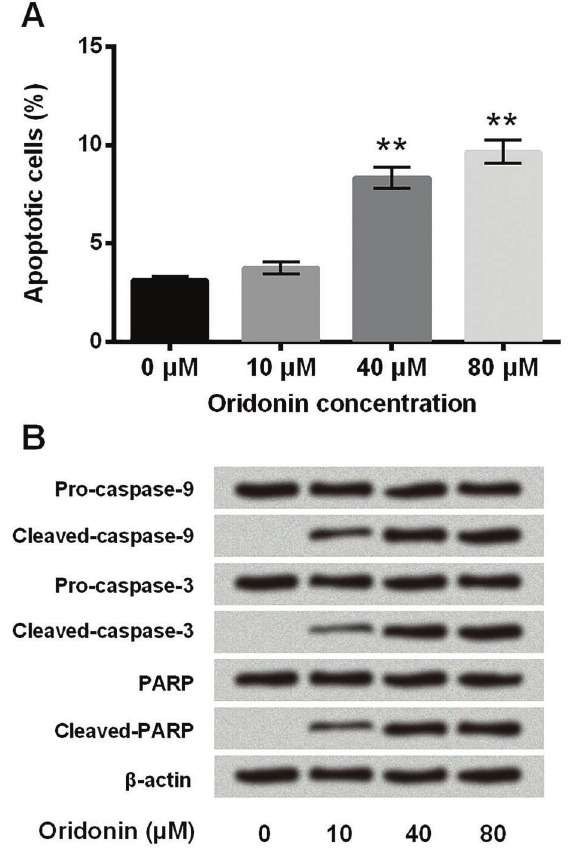
Figure 2. Oridonin promoted apoptosis in SNU-216 cells. SNU- 216 cells were treated with oridonin (0, 10, 40 and 80 m M) for 24 h. A , Percentage of apoptotic cells was determined by fl ow cytom- etry assay, and B , expression of apoptosis-related proteins was detected by western blot. Data are reported as means ± SD. **P o 0.01 compared to 0 m M